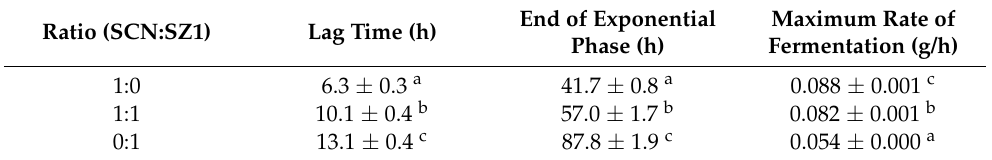
Table 4. Fermentation kinetics of S. cerevisiae (SCN) and S. pombe (SZ1) monocultures, and mixed culture at 1:1 initial inoculation ratio in high-gravity wort